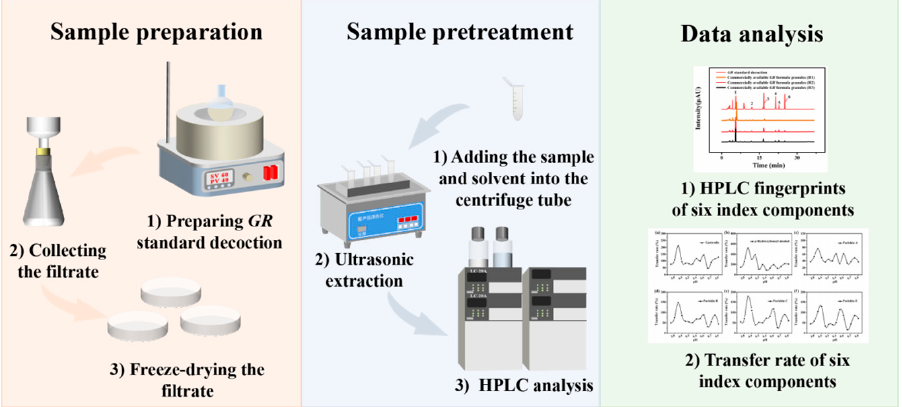
Figure 1. A simplified workflow illustrating the preparation, pretreatment, and detection process of GR formula granules.